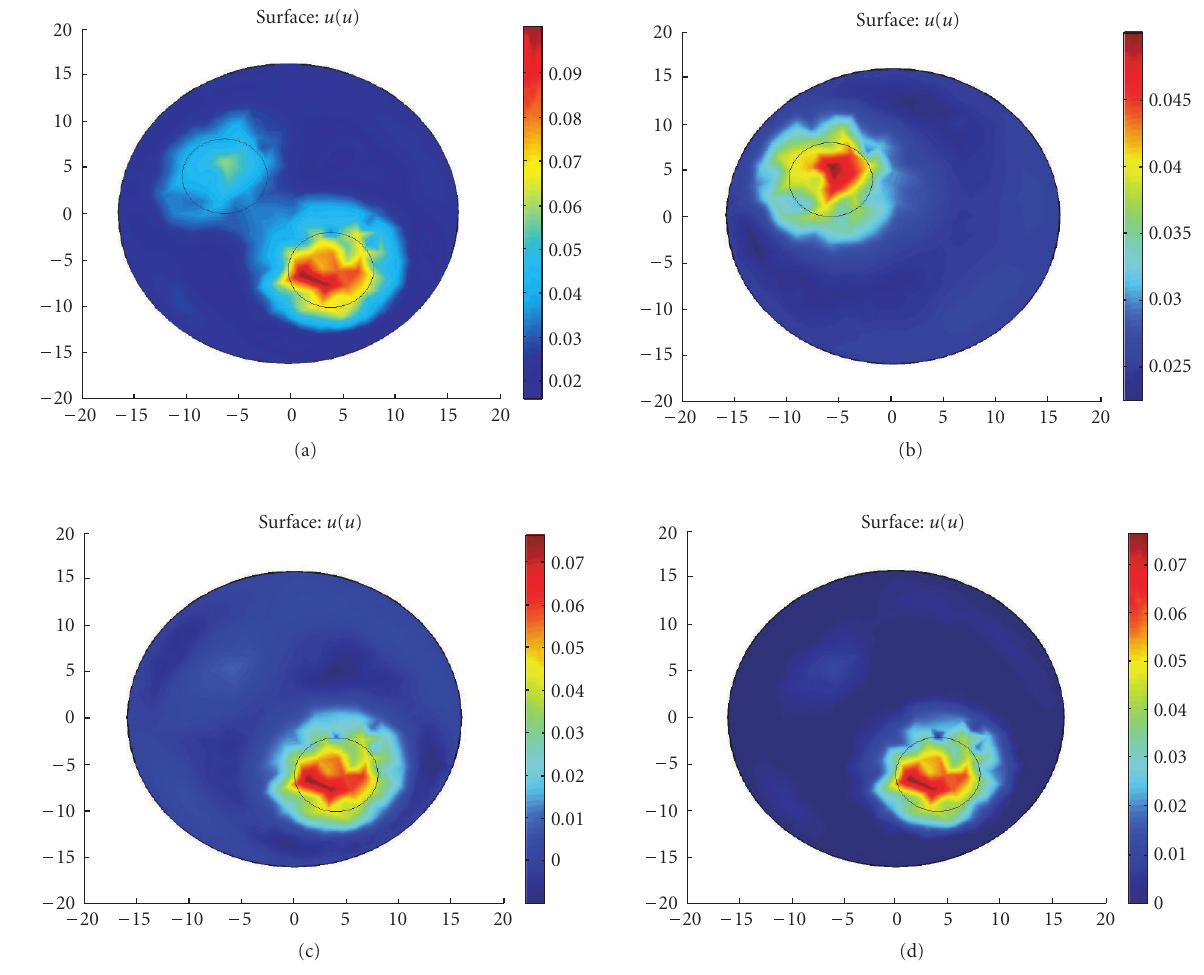
Figure 3: Images obtained in the case when FA and HA are apart from each other. (a) and (b) are, respectively, the independent reconstructed images of μ a ( r ) + ε c ( r ) and μ a ( r ). (a) minus (b) educed (c), describing the concentration of fluorochome. (d) constrains the negative values in (c) to zero. The black circles represent the original exact locations and shapes of HA and FA. The original μ a ( r ) is 0 . 05 mm (cid:0) 1 in the left 6,4) and is 0 . 025 mm (cid:0) 1 in the rest. ε c ( r ) is 0 . 075 mm (cid:0) 1 in the right 8 mm-diameter circle centred at 8mm-diameter circle centred at ( (cid:0) 6) and is zero in the (4, (cid:0)